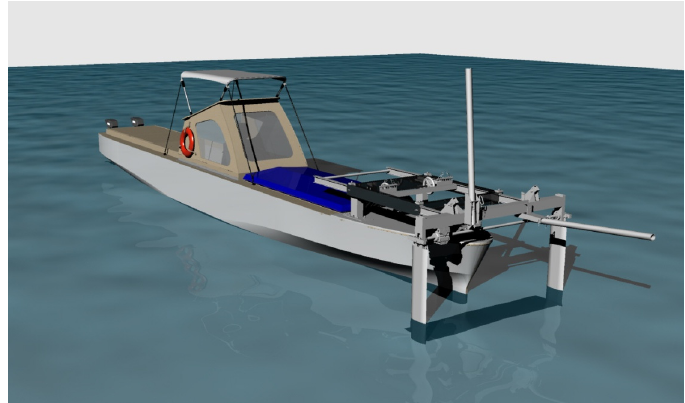
Figure 19. CAD model of large-scale model to be tested at